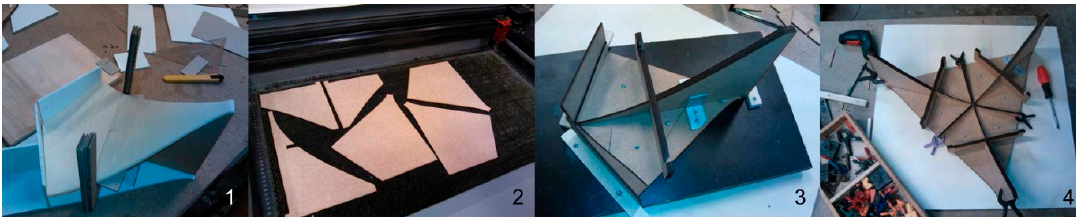
Figure 7. Preparation of moulds: ( 1 ) cardboard mould to serve as test; ( 2 ) MDF laser cut pieces with 3 mm; ( 3 ) sub-mould in MDF with 3 mm to help building one third of the shell; and ( 4 ) complete mould in MDF with 3 mm.